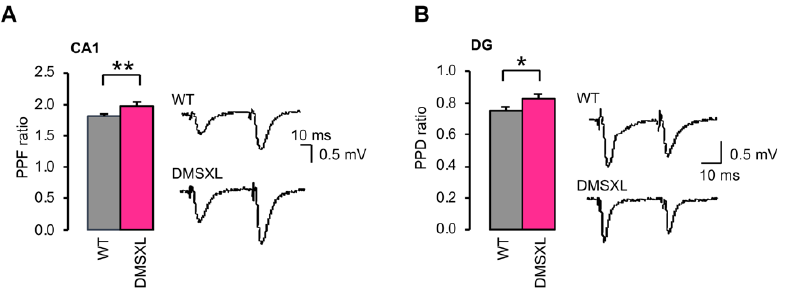
Figure 4. Short-term plasticity in CA1 and DG. ( A ) PPF in CA1. For PPF measurement, the slope of the second response was normalized by the slope of the first one. The PPF ratio was significantly higher in slices from DMSXL mice ( n = 24 mice, n = 55 slices) than in WT controls ( n = 24 mice, n = 58 slices). ** p = 0.006. ( B ) PPD in DG. The PPD ratio was significantly increased in DG slices from DMSXL mice ( n = 7 mice, n = 23 slices) relative to WT animals ( n = 9 mice, n = 29 slices). * p = 0.038.